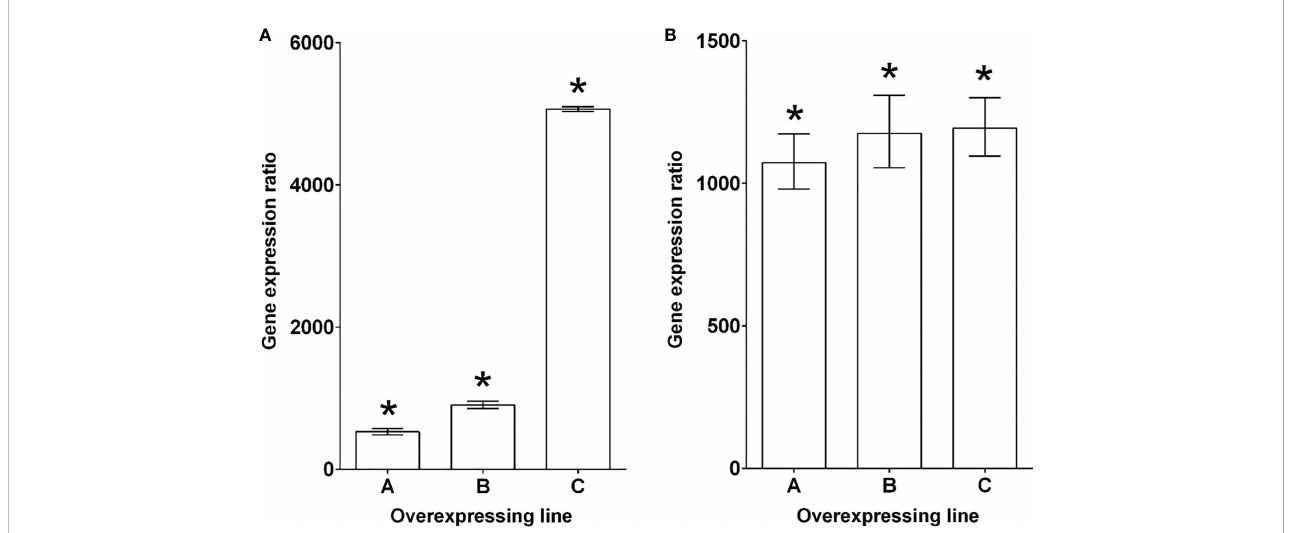
FIGURE 4 Characterization of PECP2 overexpressing lines in fugu5 mutant backgrounds. Lines that overexpress PECP2 in the fugu5-1 (A) and fugu5-3 (B) backgrounds show very high transcript levels for these phosphatases, even in the high Pi condition. The results are expressed as gene induction level in overexpressing lines (#A to #C) in comparison to their respective fugu5 controls grown under the same conditions. fugu5 control values were arbitrarily set to one. The results are presented as the median ± 95% con fi dence interval. Asterisks indicate a statistically signi fi cant difference between overexpressing lines and fugu5 (REST randomization test, P < 0.05). The reference genes used for the individual panels were ROC3 and GAPC1